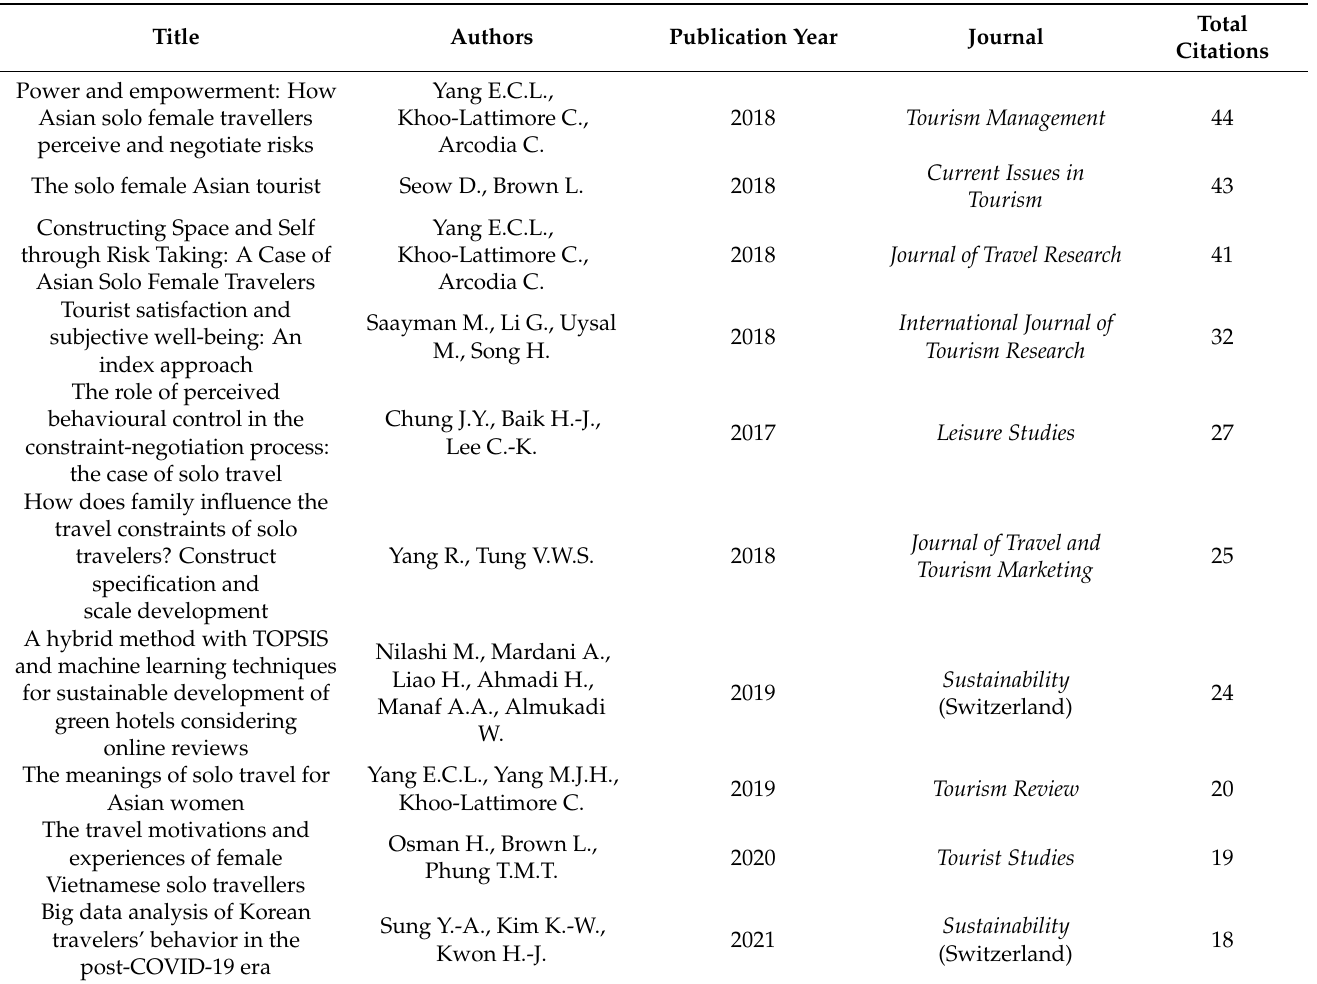
Figure 7. Top authors contributing to the subject of “Solo Travel” (at least two articles published). Table 2. Top 10 most cited articles on the subject of “Solo